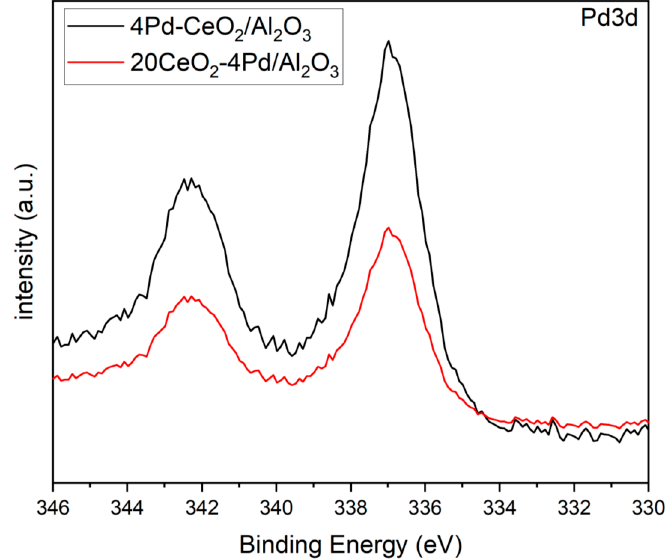
Figure 1. XPS in Pd3d regions of the two catalysts.